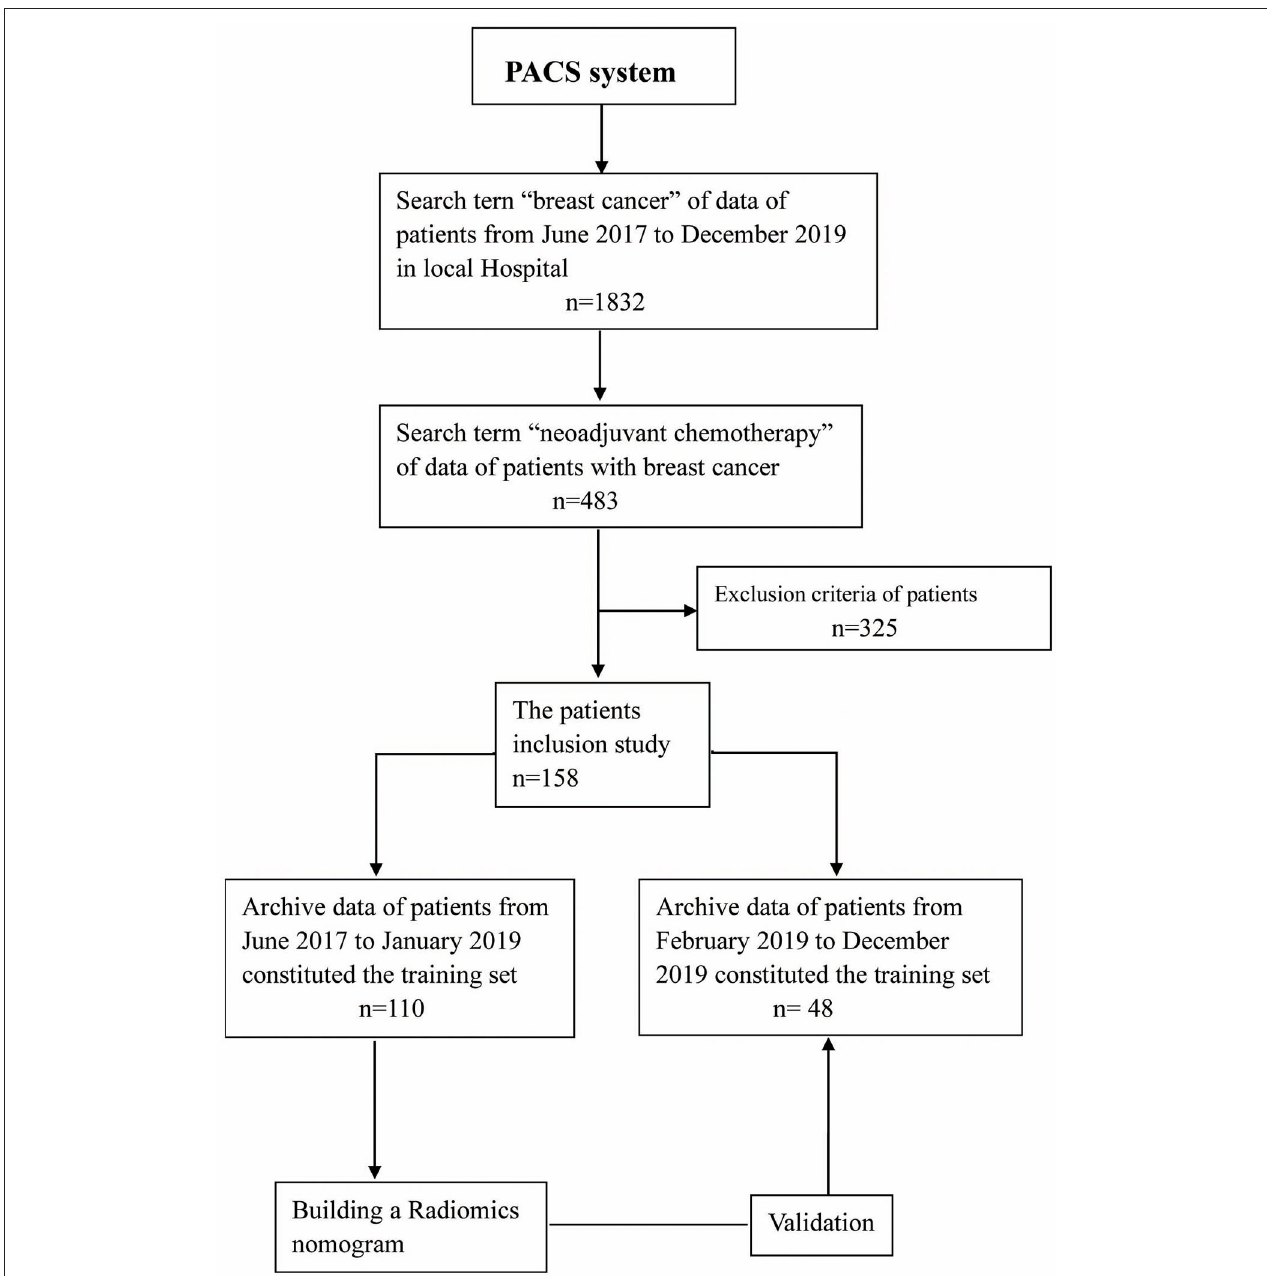
FIGURE 1 | Flowchart showing the recruitment of patients and the overall design of this retrospective study.